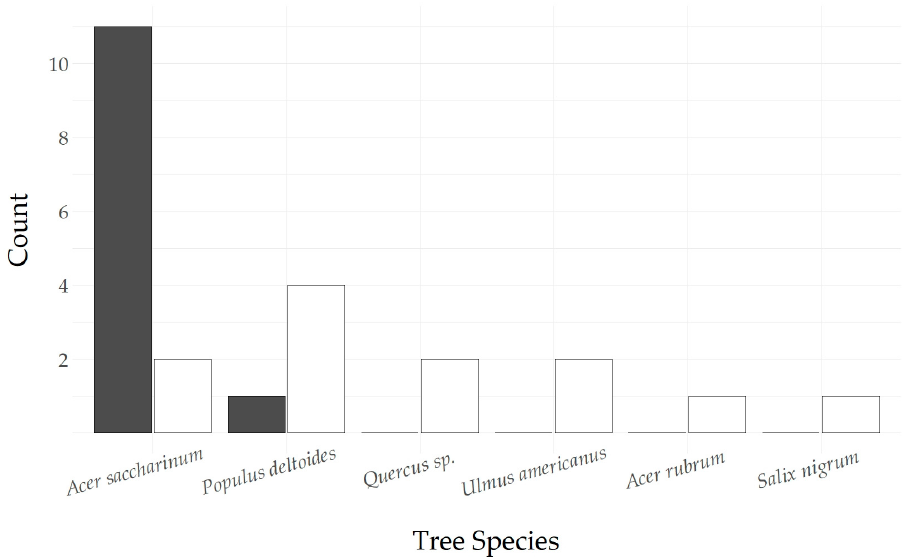
Figure 2. Tree species used by a population of northern long-eared bats ( Myotis septentrionalis ) as roosts (black) and available trees within foraging range (white) of capture locations in Fox Island County Park in Fort Wayne, IN. Data were collected between May and August 2019–2021. Bats preferentially selected for silver maples ( Acer saccharinum ; p < 0.01).